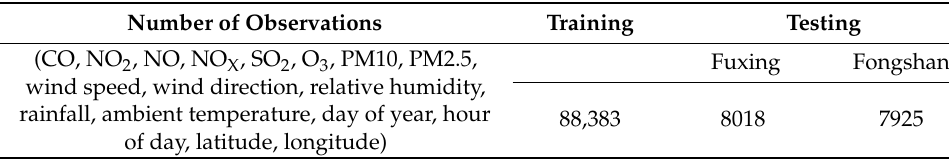
Table 1. Number of observations for training and